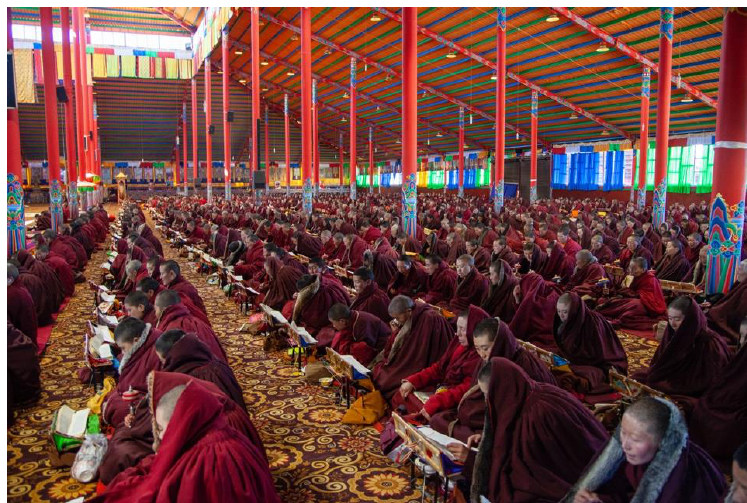
Figure 2. Behind the large encampment, several public buildings served for the ritual practices of the nuns. In one of them, we encountered hundreds of nuns chanting sutras.